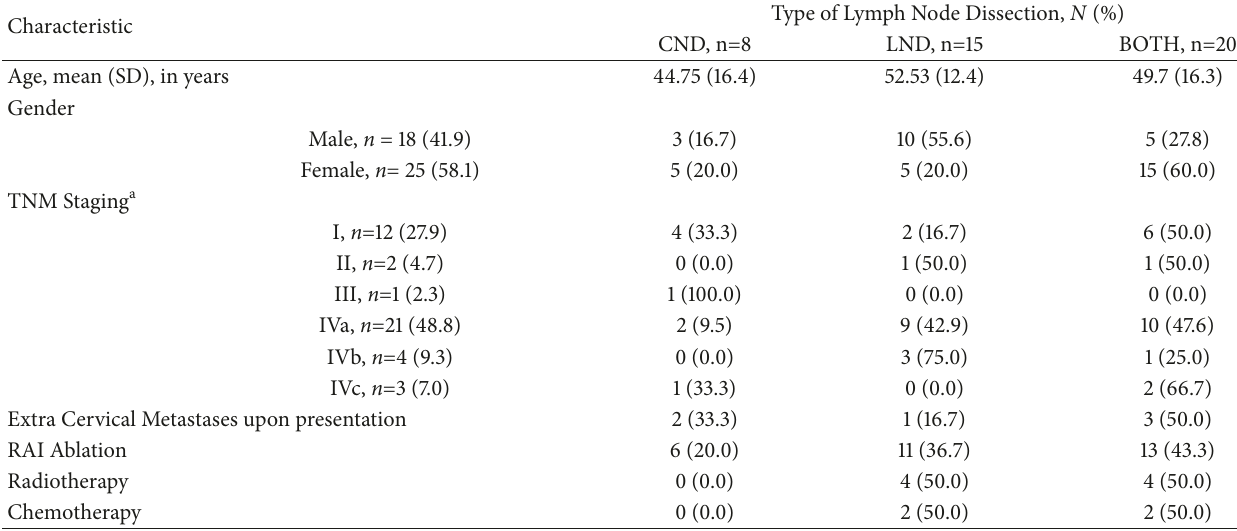
Table 1: Patients’ demographic characteristics.